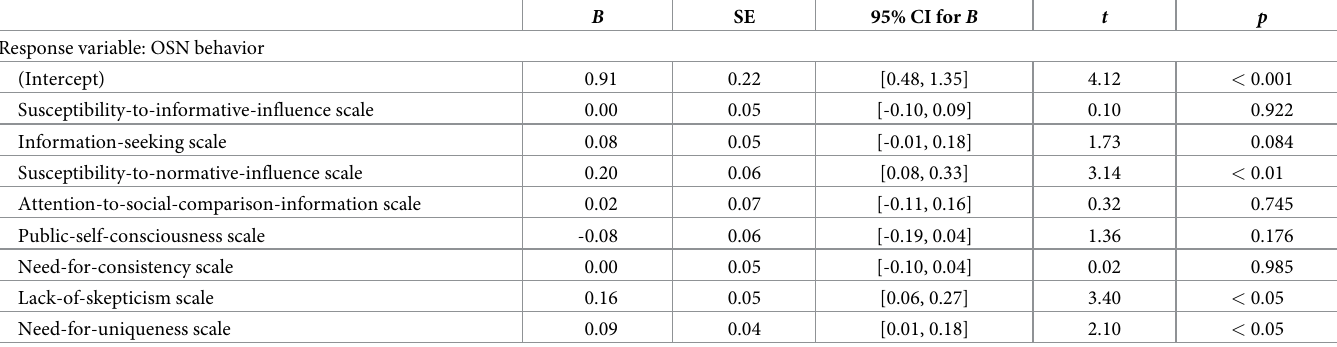
Table 2. Testing whether SSI scales predict OSN behavior.